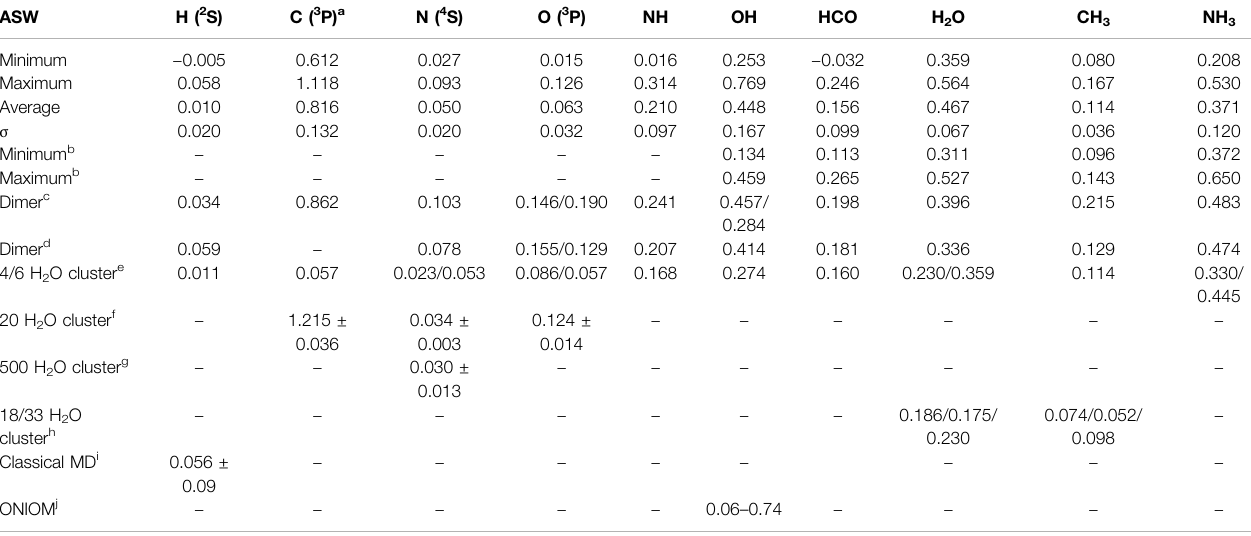
TABLE 5 | Calculated BE ’ s at CBS/DLPNO-CCSD(T):PM6// ONIOM( ω B97X-D/6-31+G**:PM6) including ZPE for amorphous structures. ASW H ( 2 S) C ( 3 P) a